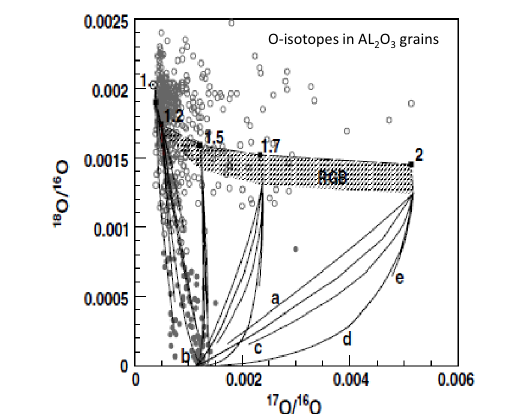
Figure 3. Isotopic anomalies in presolar grains of Al 2 O 3 , recovered from pristine meteorites, versus predictions of stellar models. The abundance sequence expected by the standard evolution of RGB stars from 1 to 2 M (cid:4) does not reproduce the presolar grain evidence, especially for grains more heavily depleted in 18 O. They are however accounted for by models assuming slow, extended mixing along the RGB and AGB phases. This is shown by the model curves extending downwards from the RGB region. They represent the isotopic abundances achieved assuming extra-mixing at di ff erent speeds (progressively slower from a to e) for di ff erent initial masses. This also shows that most 18 O-depleted corundum grainds descend from very low mass stars (left side of the figure). See also [21]; the figure is adapted from that